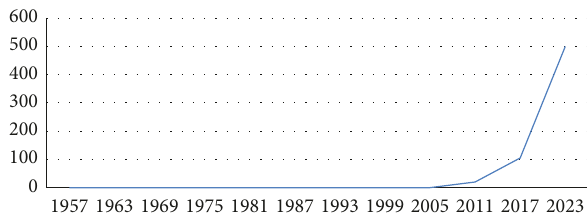
Figure 3: Article distribution by years for rapid review articles.